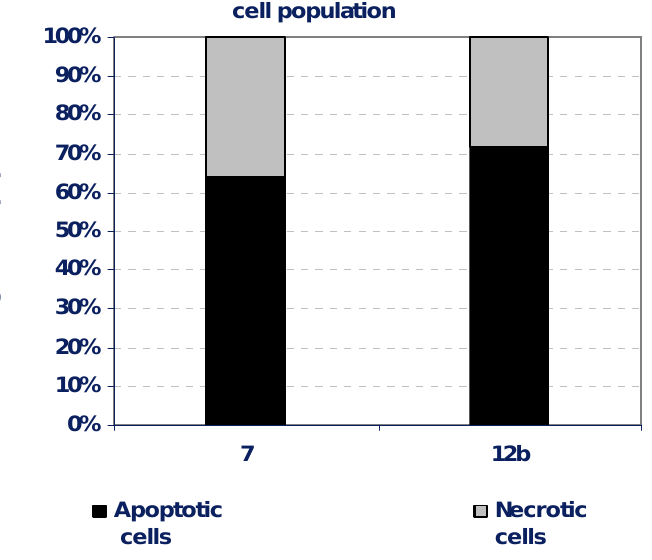
Table 3. Percentage of induced apoptotic and necrotic cells in MCF-7 cells. Compd.